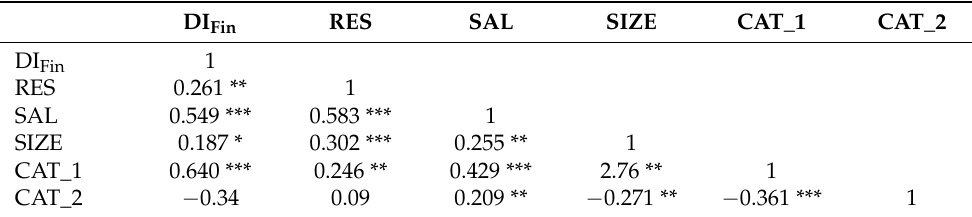
Table 8. Correlation matrix for financial